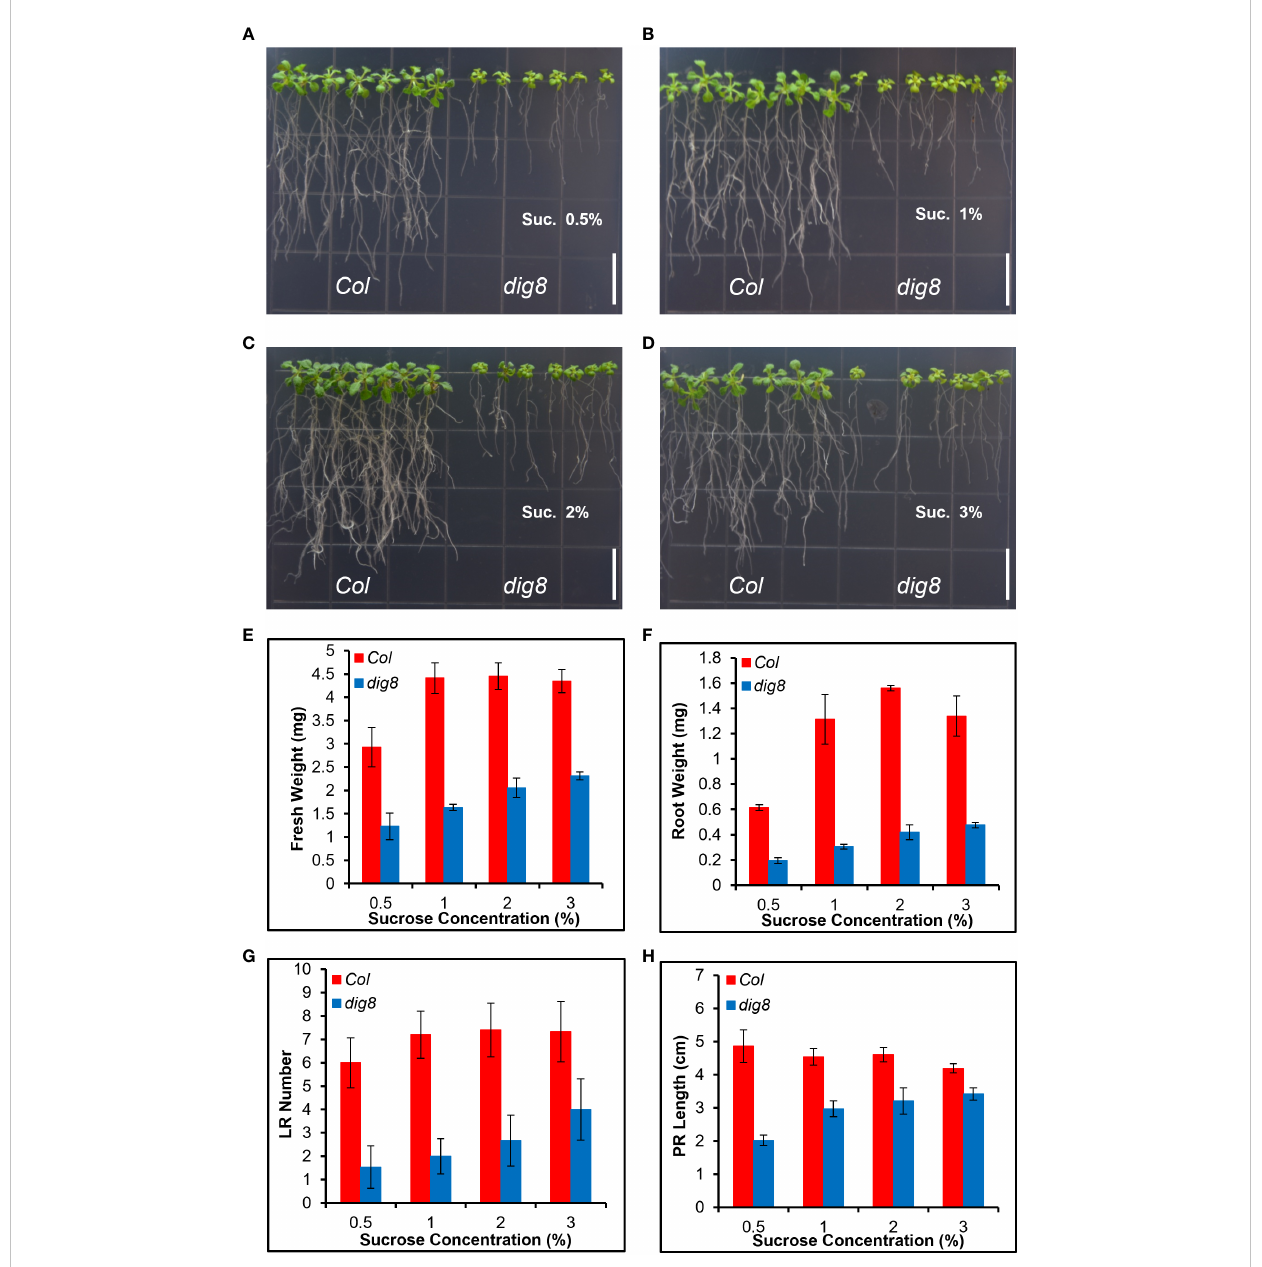
FIGURE 8 The dig8 mutant phenotype can be partially rescued by sugar supplementation. (A – D) , Col and dig8 mutant grown on MS media supplemented with sucrose at the rate (w/v) of 0.5% (A) , 1% (B) , 2% (C) , or 3% (D) , respectively. Scale bar, 1 cm.10-d-old seedlings were transferred to the shown vertical plates and pictures were taken 2 weeks after the transfer. (E – H) , fresh weight (E) , root weight (F) , lateral root number (G) and primary root length (H) of Col and dig8 mutant seedlings at different sucrose concentrations. Error bars represent SD ( n